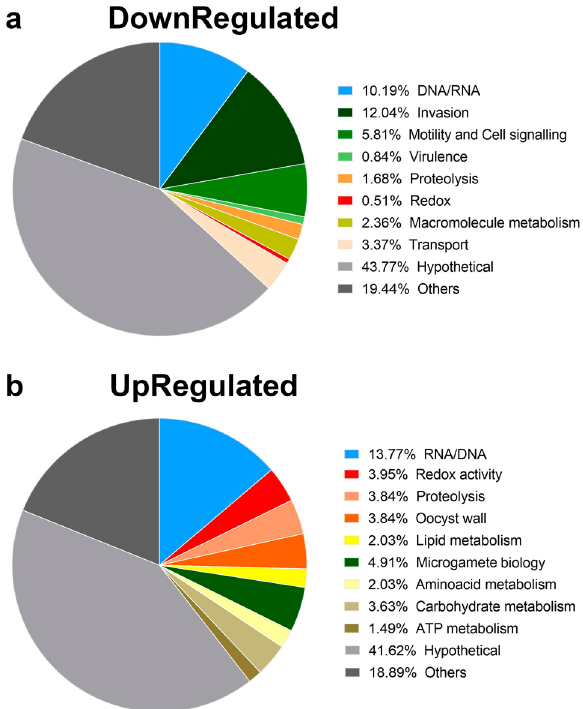
Figure 4. Biological functions of proteins coded by downregulated (a) and upregulated (b) genes. The biological functions of proteins coded by each of the 1188 down- and 937 upregulated transcripts was assigned manually based on ToxoDB®, Blast2Go® or previously published annotations. The pie charts represent the relative proportion of these different biological functions within up- and down regulated